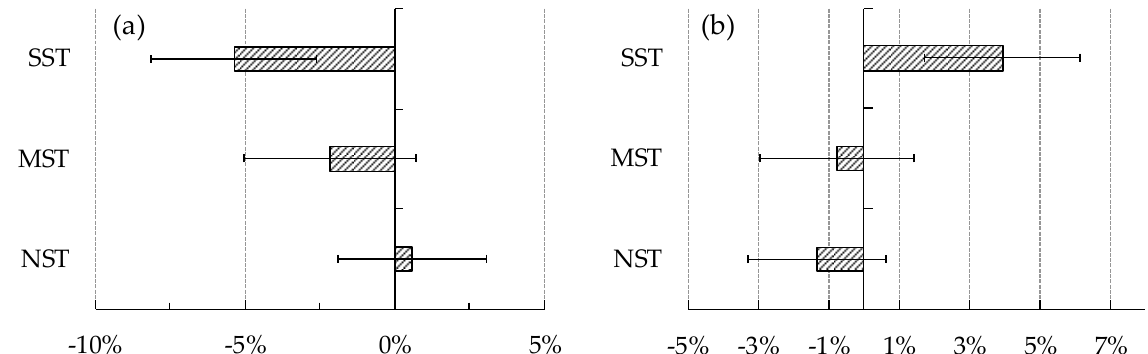
Figure 6. Effect of average temperature on double rice yield. ( a ) early rice; ( b ) late rice. NST, MST and SST indicate the northern subtropical zone, middle subtropical zone and south subtropical zone, respectively. (early rice: R 2 = 0.293, p = 0.036; late rice: R 2 = 0.401, p < 0.001, n = 66).